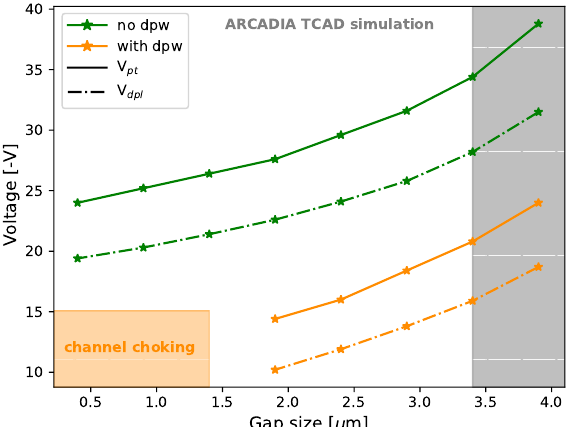
Figure 18. Sensor depletion voltage V dpl and punch-through voltage V pt as a function of the gap size for different sensor layout configurations. The orange region indicates the forbidden region due to the observed channel choking